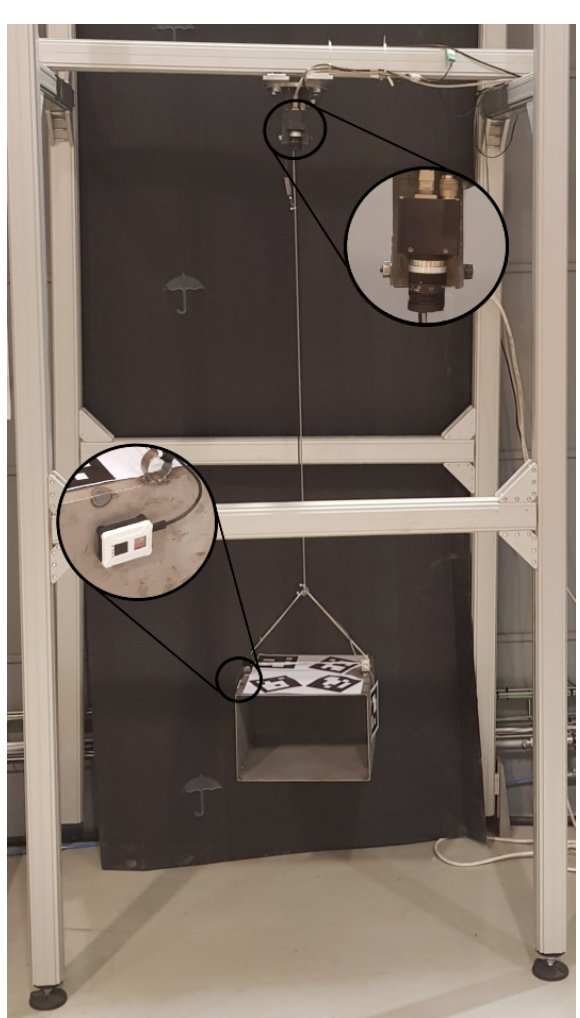
Figure 4: Experimental setup. Aruco markers and an IMU were fixed to the payload and an Eth- ernet camera was mounted close to the static pivot point. The wire length was l = 1 . 24 m and the Aruco markers had sides of length 9 . 7